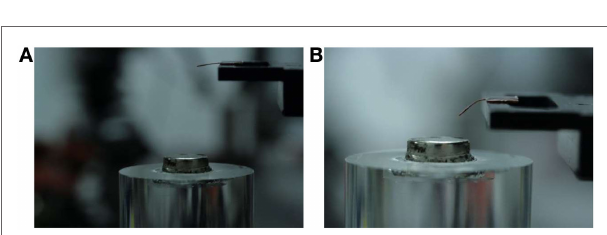
FigUre 7 | cantilever defined with sample s 4 positioned over a permanent magnet, showing (a) no deflection for weak magnetic fields (i.e., more than 3 cm between the cantilever and the permanent magnet) and (B) deflection under comparatively larger magnetic